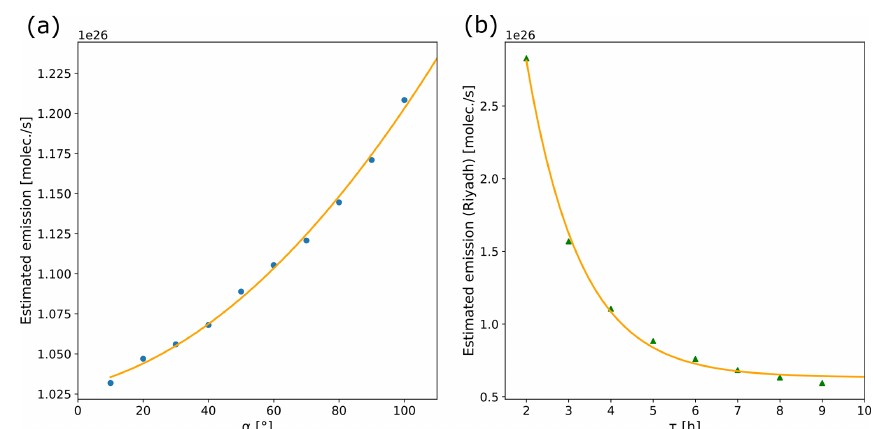
Figure 7. Estimated emissions using a different cone angle α (a) and NO 2 lifetime τ (b) based on TROPOMI data in Riyadh in